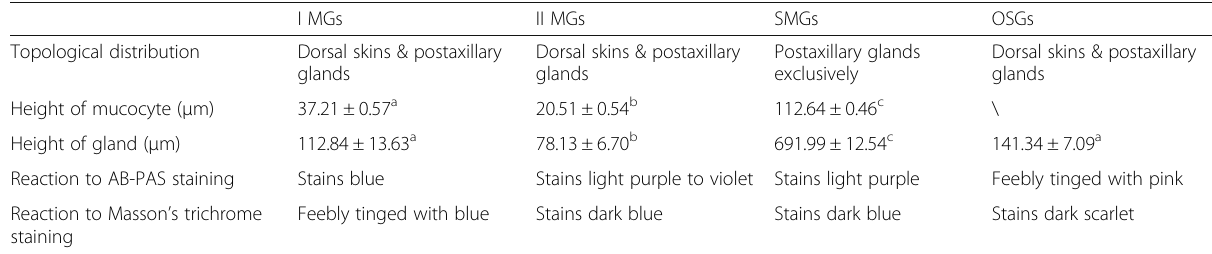
Table 1 Morphological and histochemical characteristics of the four types of simple alveolar glands in N. pleuraden I MGs II MGs SMGs OSGs Topological distribution Dorsal skins & postaxillary Dorsal skins & postaxillary Postaxillary glands Dorsal skins & postaxillary glands glands exclusively glands Height of mucocyte ( μ m) Height of gland ( μ m) Reaction to AB-PAS staining Stains blue Stains light purple to violet Stains light purple Feebly tinged with pink Reaction to Masson ’ s trichrome Feebly tinged with blue Stains dark blue Stains dark blue Stains dark staining